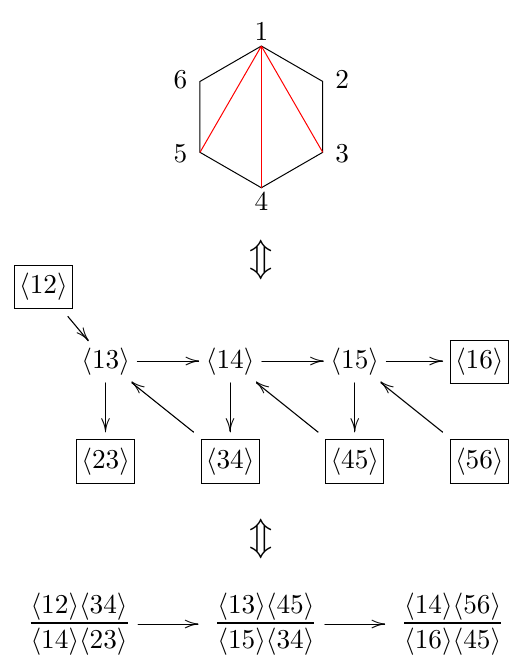
Figure 2. A triangulation of the hexagon along with its assocated A -coordinate and X -coordinate seed